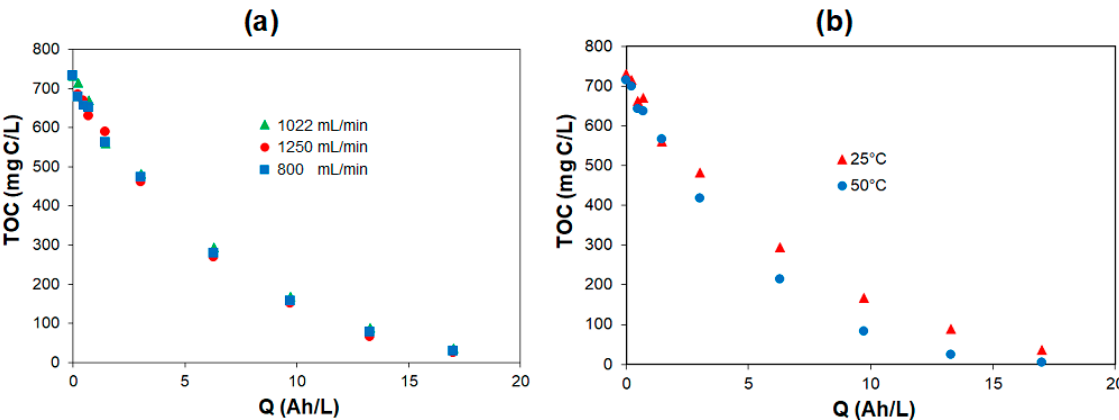
Figure 4. Effects of ( a ) flow rate and ( b ) temperature on the changes of TOC with the specific electric charge during electrolytic treatment of synthetic urine at pH 5.5 using a BDD anode and stainless steel cathode at different 20 mA/cm 2 .